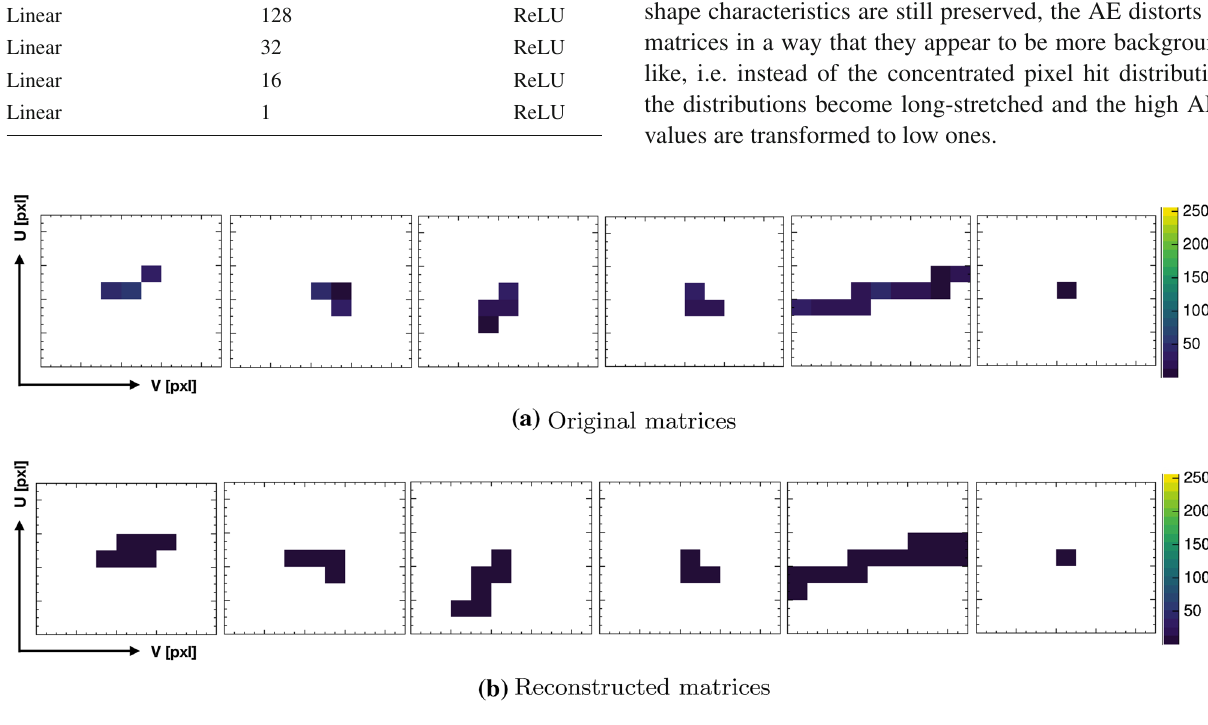
Fig. 7 a Input and b reconstructed pixel matrices associated with background